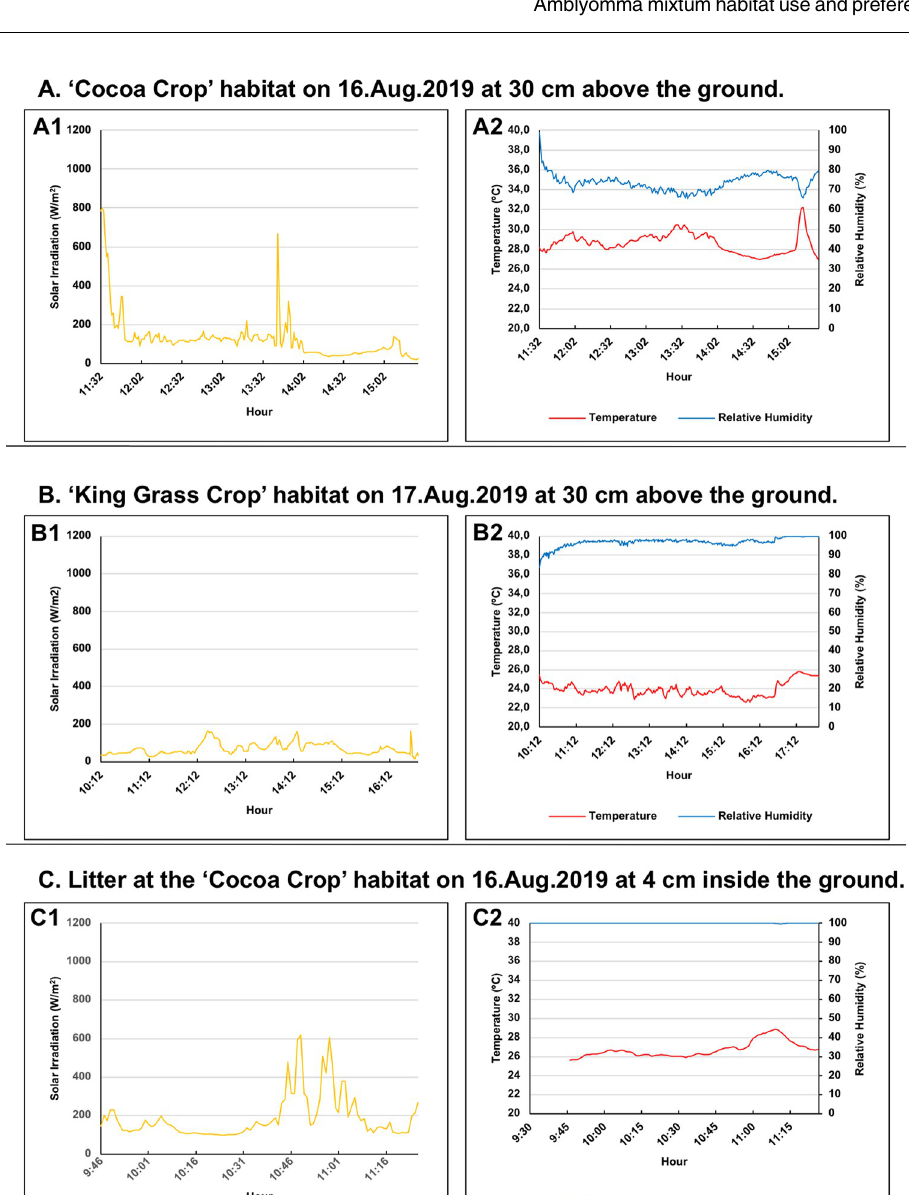
Fig 7. Plots of microclimatic variables that were measured in situ for two habitats in the wet season. (A). Cocoa Crop habitat. (A1). Solar irradiation values (W/m 2 ) (N = 236; � w � = 126.4; SD = 118.3; Max = 798.1; Min = 19.4) according to the daytime hours. (A2). Temperature values (˚C; red line) (N = 236; � w � = 28.6; SD = 1.0; Max = 32.2; Min = 27.0) and relative humidity (%; blue line) (N = 236; � w � = 73.6; SD = 4,3; Max = 98.6; Min = 65.4) according to the daytime hours. (B). King Grass Crop habitat. (B1). Solar irradiation values (W/m 2 ) (N = 396; � w � = 70.4; SD = 30.2; Max = 164.4; Min = 19.4) according to the daytime hours. (B2). Temperature values (˚C; red line) (N = 457; � w � = 23.9; SD = 0.7; Max = 25,8; Min = 22.6) and relative humidity (%; blue line) (N = 457; � w � = 96.9; SD = 2.3; Max = 100; Min = 83.6) according to the daytime hours. (C). Litter at the Cocoa Crop habitat. (C1). Solar irradiation values (W/ m 2 ) (N = 101; � w � = 188.7; SD = 114.1; Max = 619.4; Min = 99.4) according to the daytime hours. (C2). Temperature values (˚C) (N = 101; � w � = 26,7; SD = 0,8; Max = 28,8; Min = 25,6) and relative humidity (%) (N = 117; � w � = 99.99; SD = 0.05; Max = 100; Min = 99.6) according to the daytime